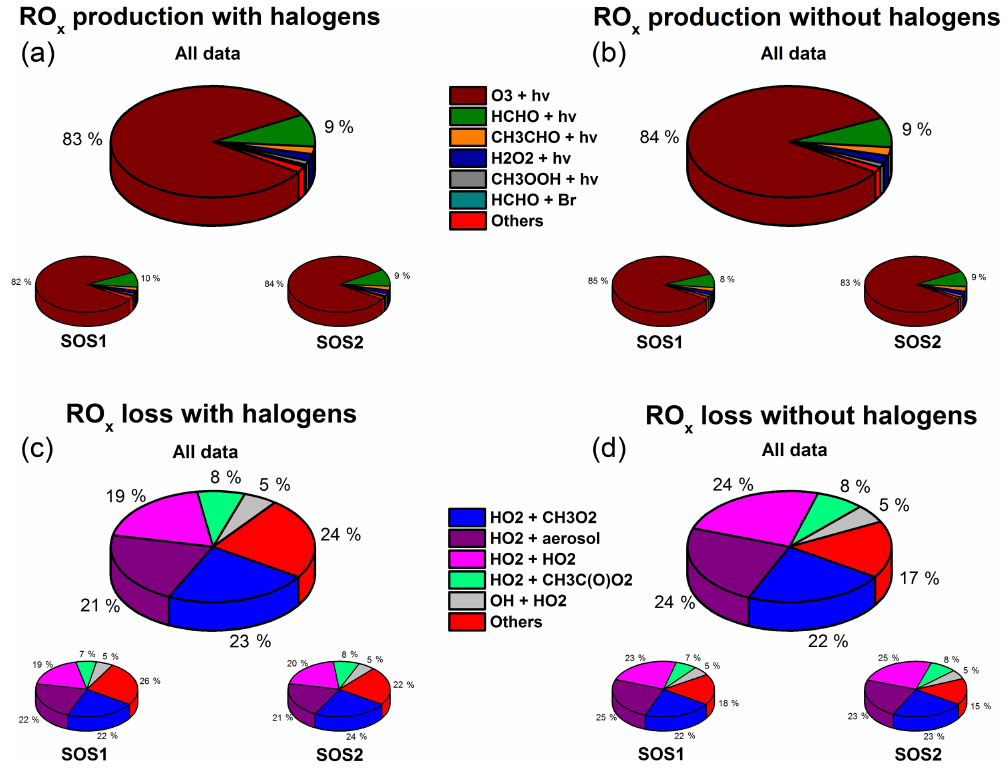
Figure 4. Processes controlling the (a) instantaneous RO x radical production (with RO x defined here as OH + HO 2 + HOBr + HOI + RO + RO 2 owing to the rapid processing between HO 2 and HOBr/HOI) around noon (11:00–13:00LT) for box model simulations with halogen chemistry; (b) the instantaneous RO x radical production around noon for box model simulations without halogen chemistry; (c) the instantaneous RO x radical loss around noon for box model simulations with halogen chemistry; (d) the instantaneous RO x radical loss around noon for box model simulations without halogen chemistry. The main charts show the average results for SOS1 + SOS2, with results for SOS1 and SOS2 shown separately in the smaller